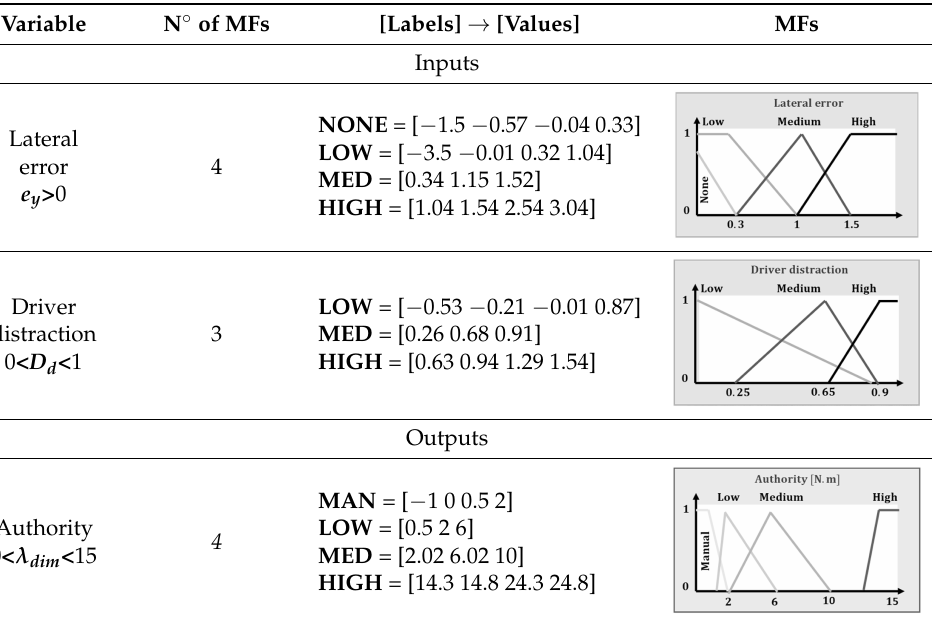
Table 5. Fuzzy inference system for the arbitration